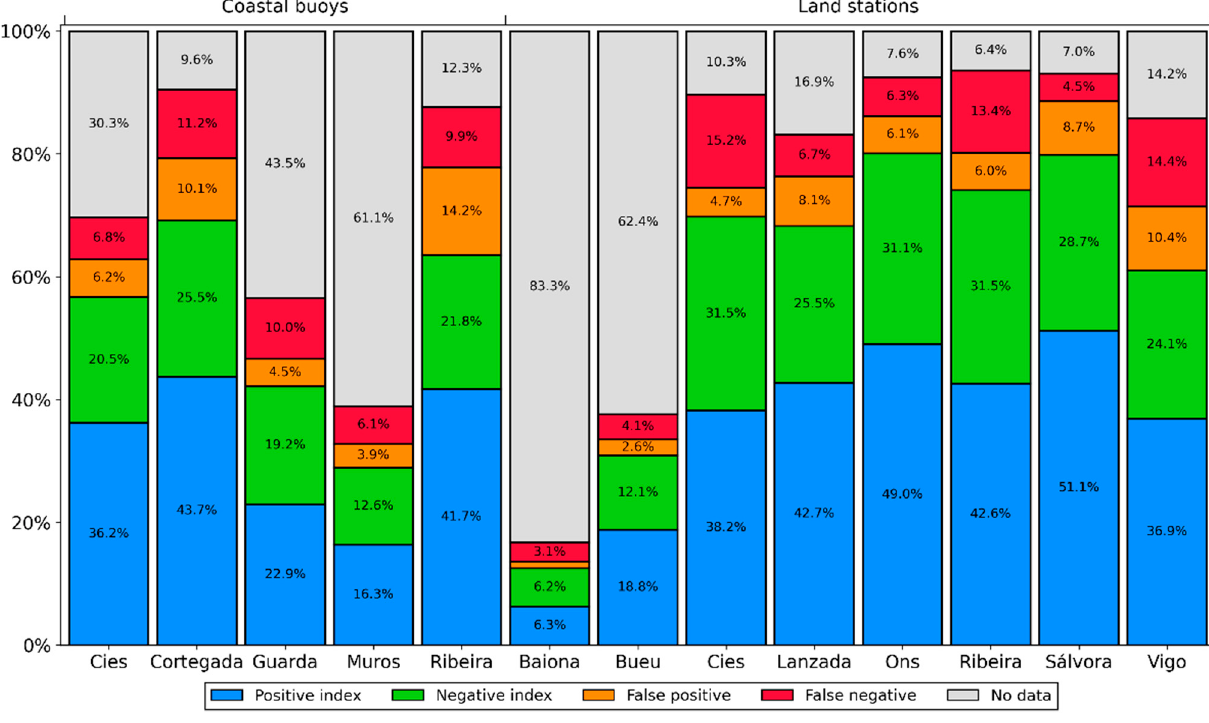
Figure 5. Concordance and divergence of UI between buoy stations and FNMOC model, including the data availability.